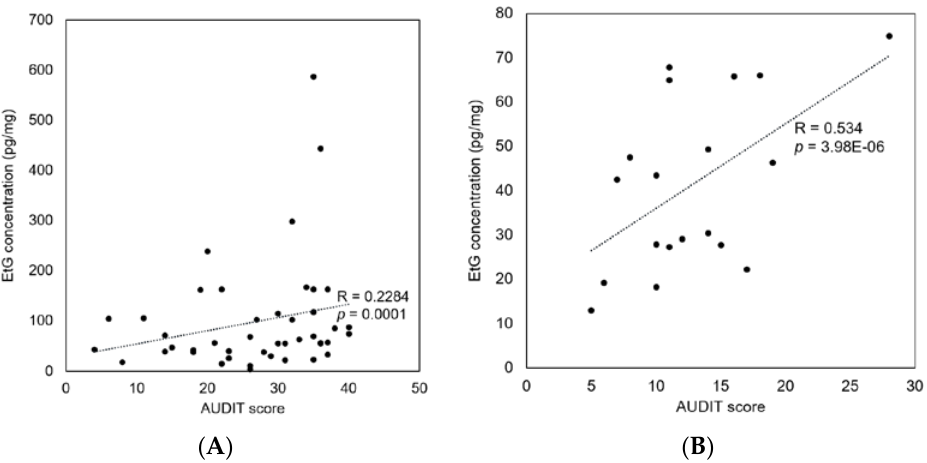
Figure 5. Correlation between the AUDIT scores and the hair EtG concentrations in alcohol addicts ( n = 44, ( A )) and average alcohol users ( n = 19, ( B )).